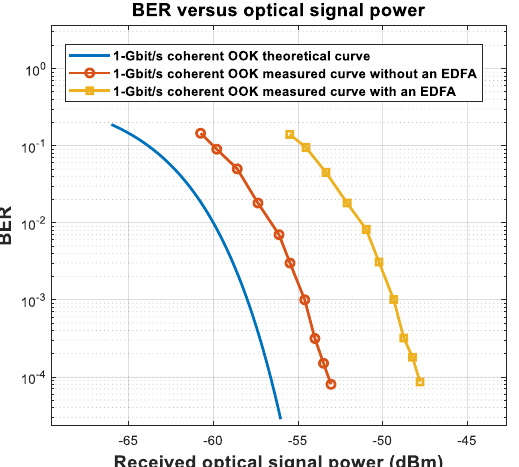
Figure 6. Measured and theoretical curves of coherent OOK BER and received signal power with a communication rate of 1 Gbit/s.